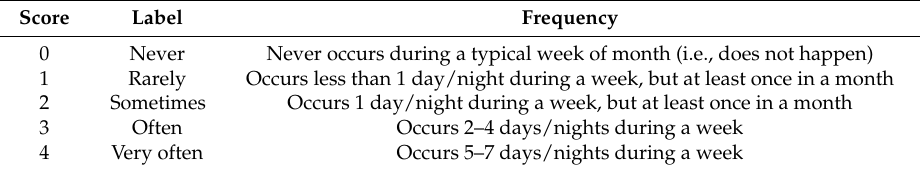
Table 2. Likert Scale Labels and Designated Frequency Anchors for HCSQ Items.